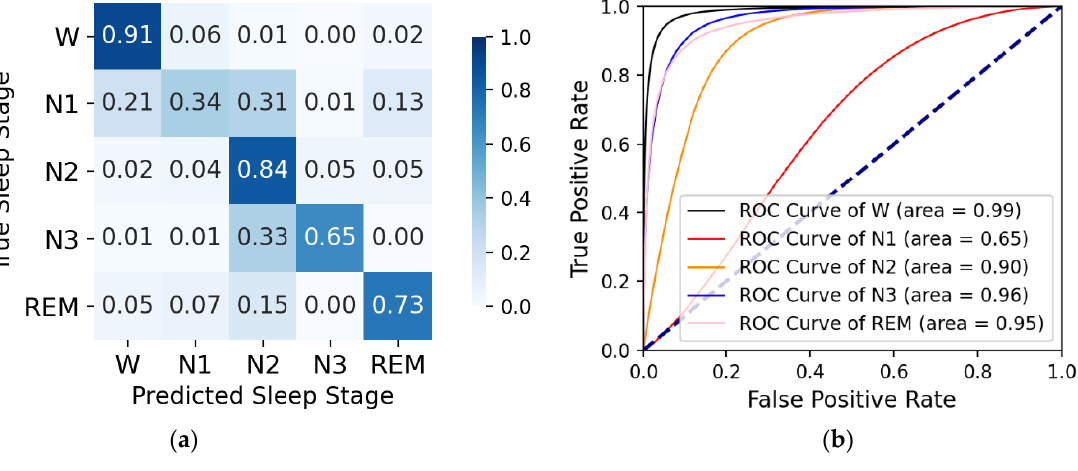
Figure 7. The CAttSleepNet model ’ s confusion matrix and ROC curve are obtained from the Pz-Oz channel of the sleep-edfx-2018 dataset. ( a ) Confusion matrix; ( b ) ROC curve.